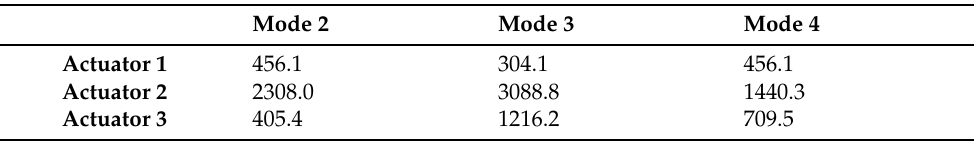
Table 5. Experimental maximum applicable gains g max , i , j evaluated for the i -th vibration mode and the j -th